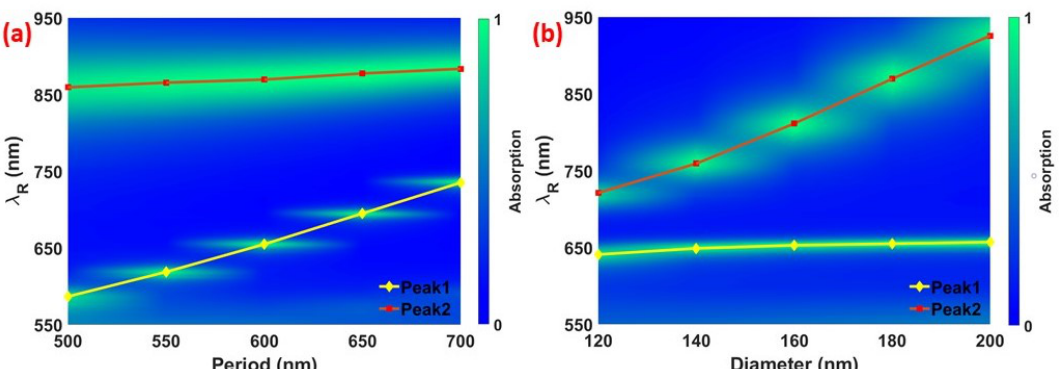
Figure 3. Absorption and resonant wavelength λ R of the system under study as a function of the array periodicity P ( a ) and diameter of the gold nanodisc D ( b ). The change on P and D present no significant effect on absorption. The dependence of Peak1 on the period confirms its PSP behavior, whereas dependence of Peak2 on the diameter confirms its LSP behavior.